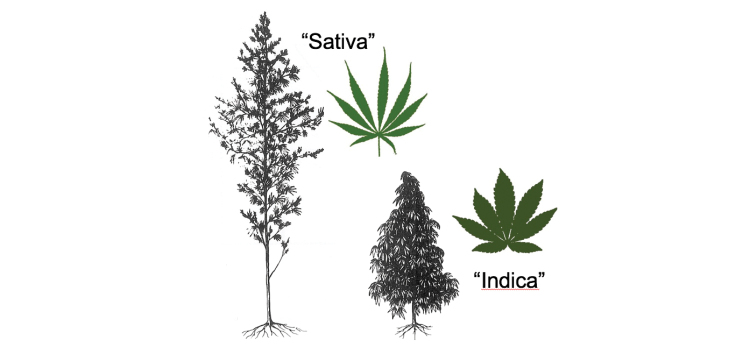
Line drawing adapted from Anderson (1980), courtesy of the Harvard University Herbaria and Botany Libraries.